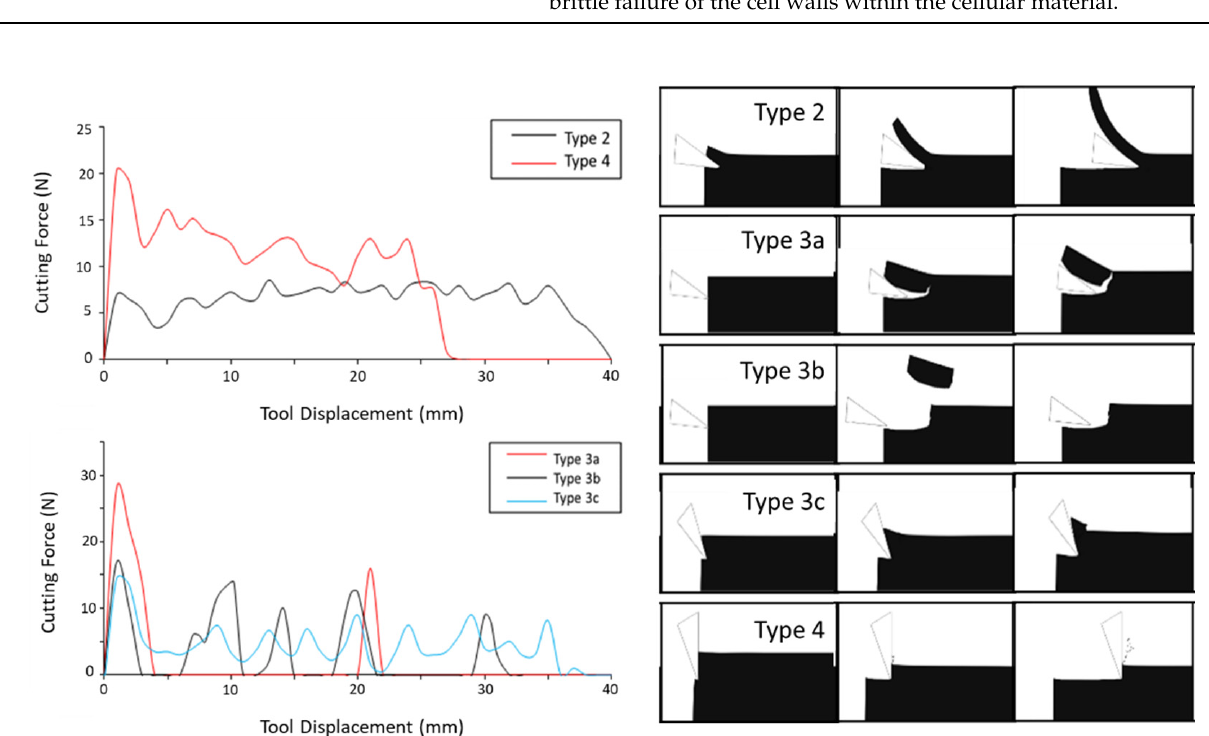
Figure 3. Schematic drawings of the types of chip formation are presented alongside the typical cutting force-tool displacement curves that correspond to each type of chip formation.